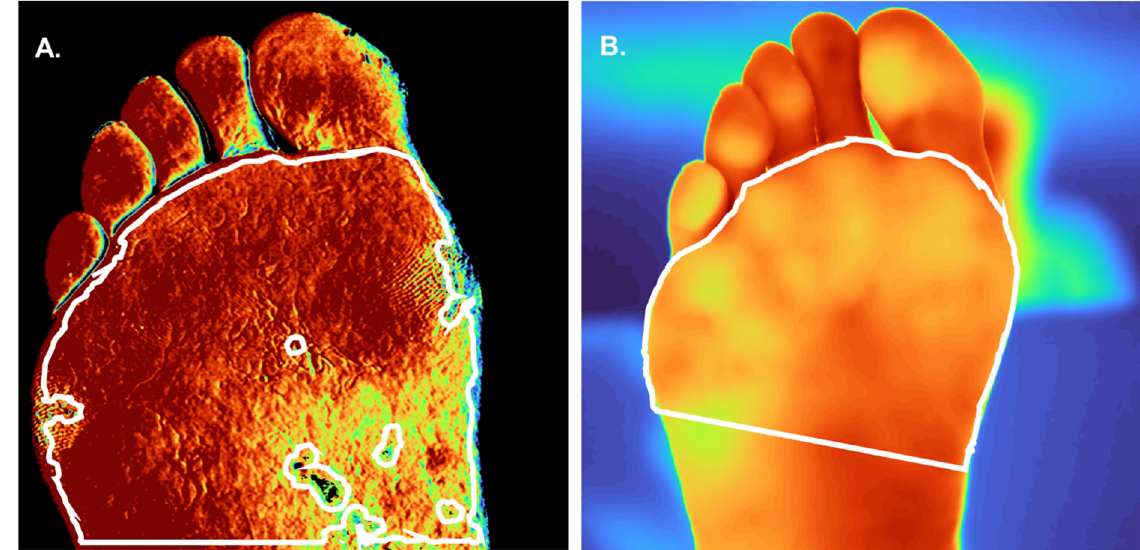
Figure 2. Example of manual segmentations of a thermal and hyperspectral image taken pre-operatively. The patient was a former smoker with Rutherford class 3. ( A ) Hyperspectral image (HSI) of oxyhemoglobin of the plantar side of the foot measured with the HyperView. A darker red color means a higher oxyhemoglobin value. ( B ) Thermal image of the plantar side of the foot measured with the forward-looking infrared (FLIR) camera. More yellow in the color of the foot means a higher temperature value. The white line represents the manual segmentation after preprocessing.